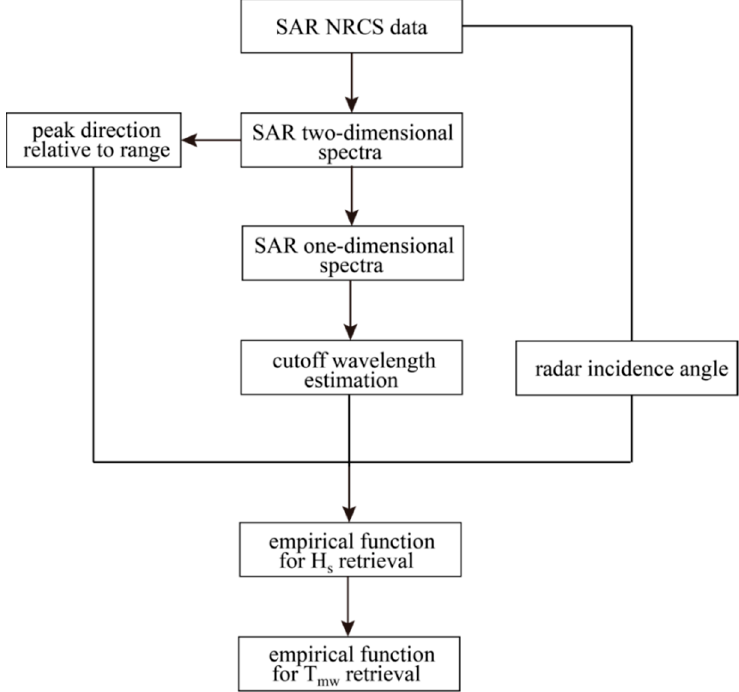
Figure 7. Block diagram of the scheme of semi-empirical wave parameters retrieval, including H s and T mw .